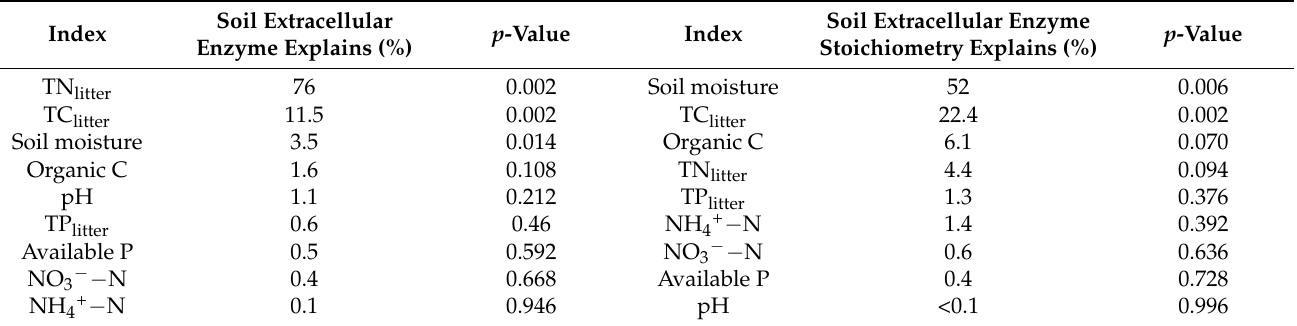
Figure 4. Redundancy analysis (RDA) used to identify the relationships between soil extracellular enzymes and soil and litter properties ( A ) and between soil extracellular enzyme stoichiometry and soil and litter properties ( B ). Table 1. The explained rate of soil and litter properties to soil extracellular enzyme activities and the soil extracellular enzyme stoichiometry determined by RDA.